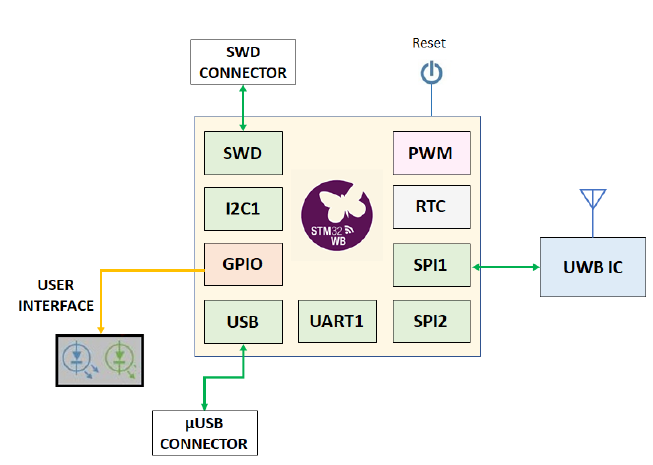
Figure 6. UWB Anchor architecture.